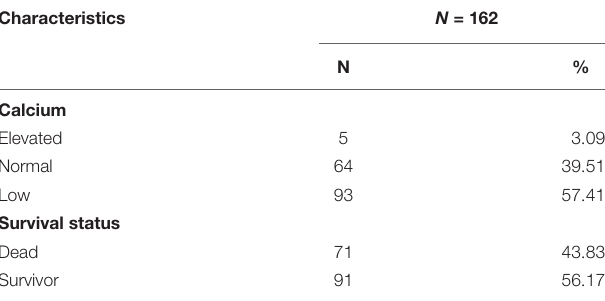
TABLE 1 | Demographics and clinical pathologic characteristics of ccRCC